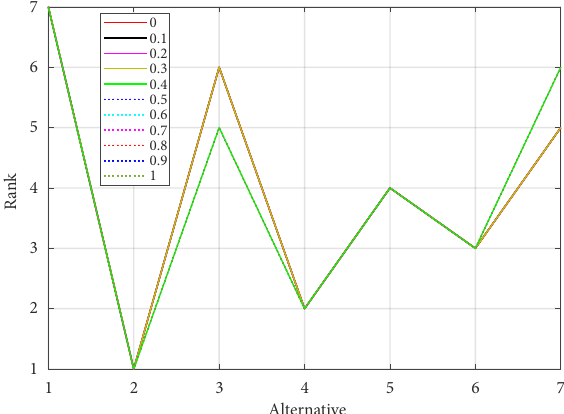
Figure 2. Rankings of alternatives obtained based on different values of